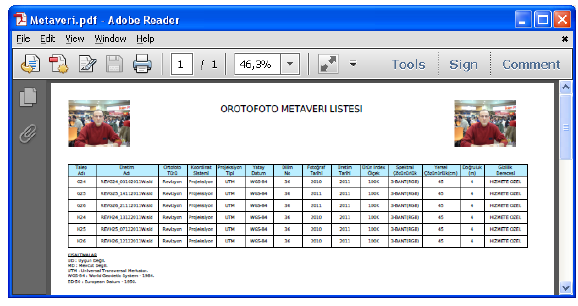
Figure 10. Orthophoto metadata list belonging to